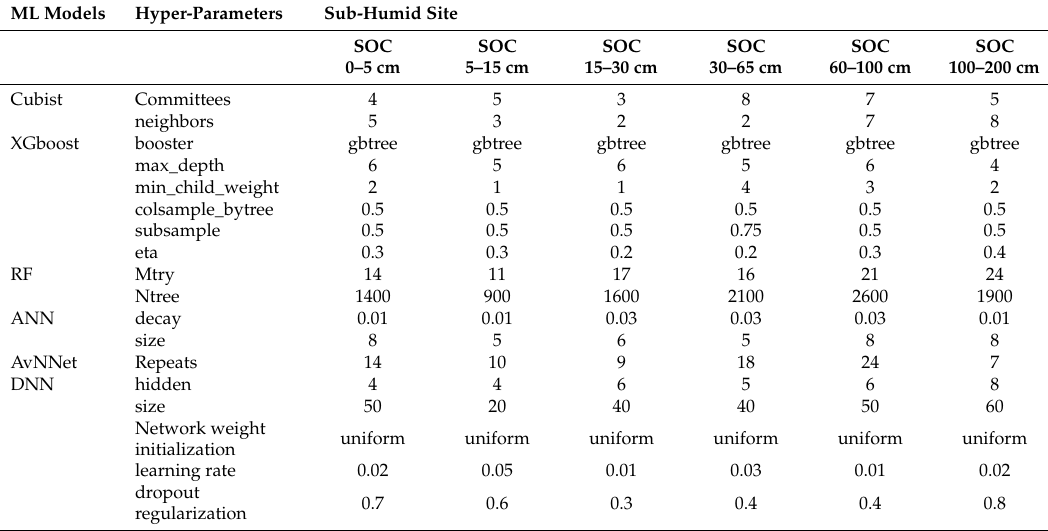
Table A2. The optimal set of hyper-parameters used for ML algorithms for prediction of SOC in the sub-humid